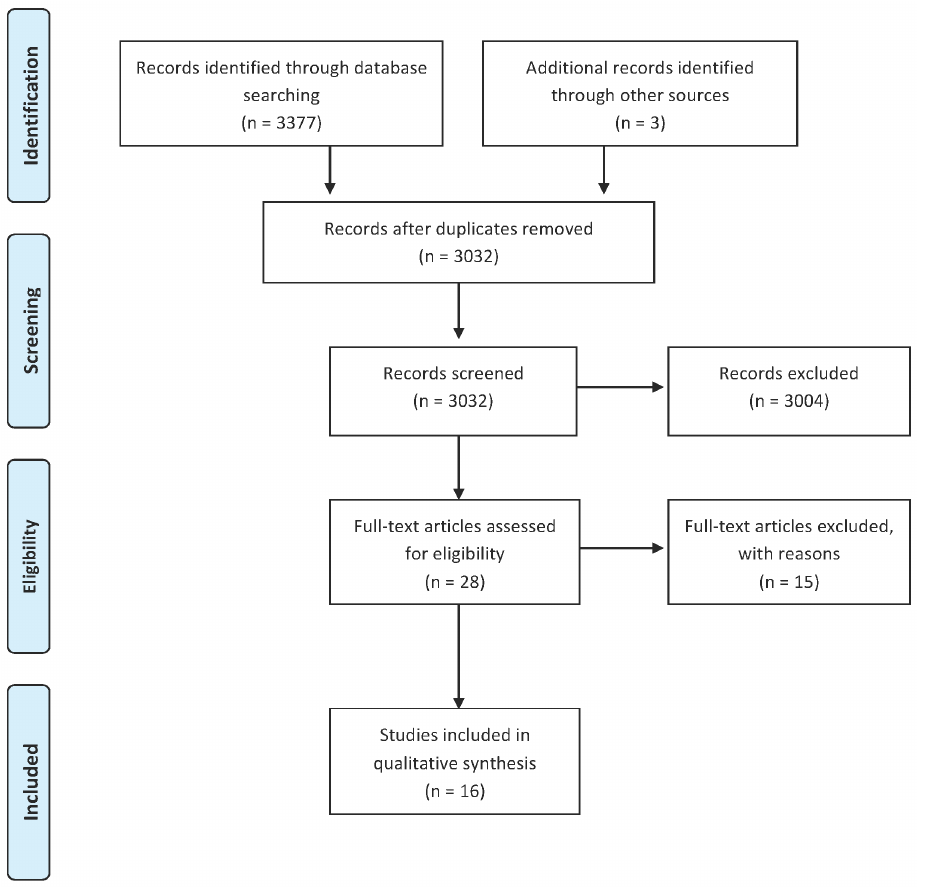
Figure 1. Preferred Reporting Items for Systematic Reviews and Meta ‐ Analyses (PRISMA) Flow Figure Diagram.